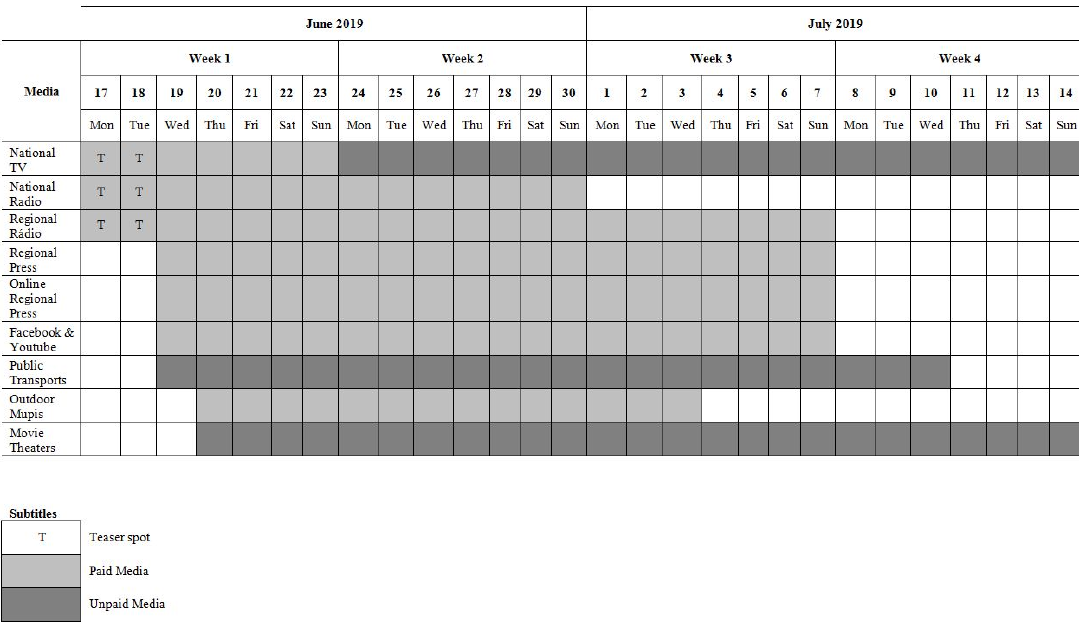
Figure 1. Campaign Figure 1. Campaign schedule.